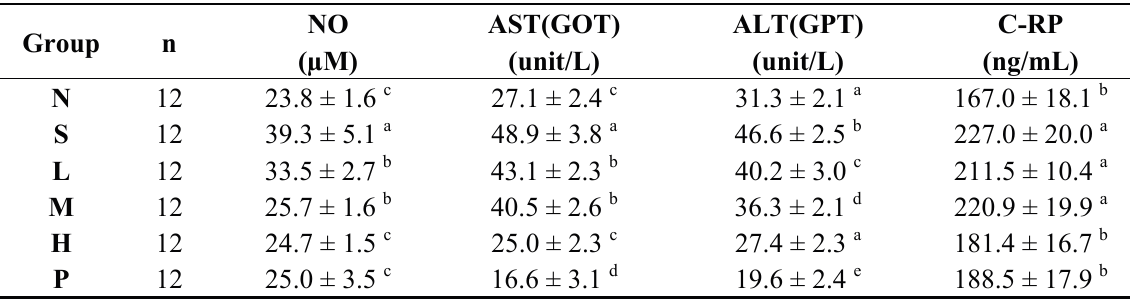
Table 4. Serum inflammatory mediator concentrations of LPS-induced sepsis